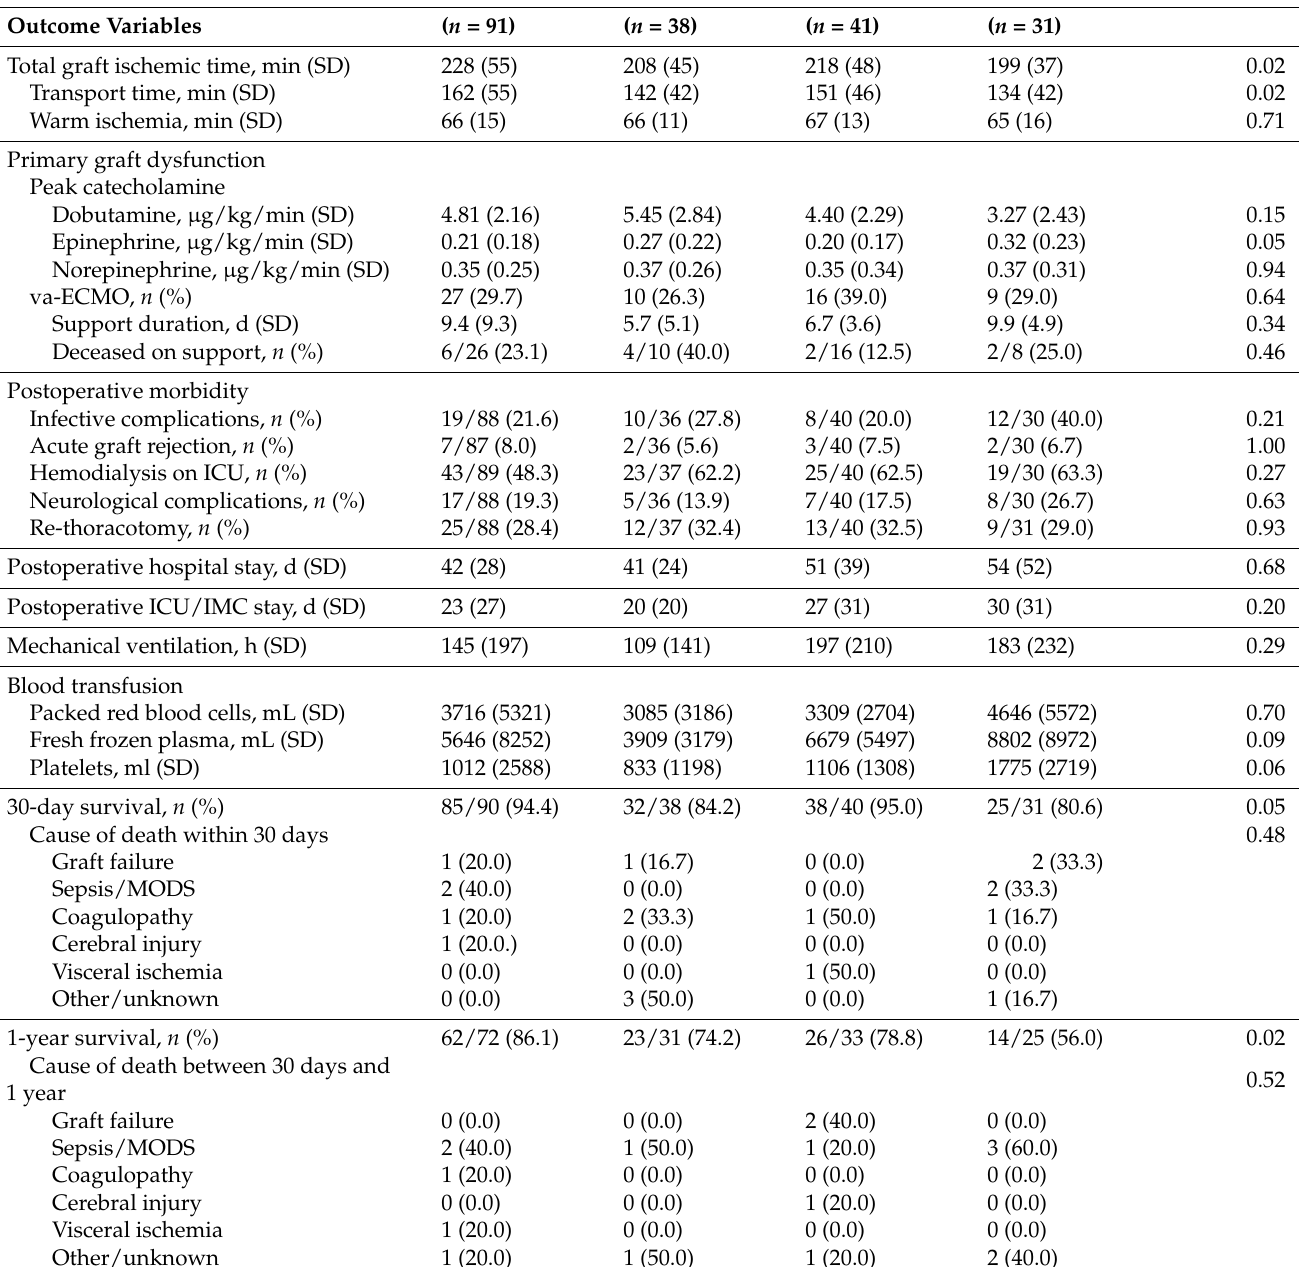
Table S1. ICU, intensive care unit; IMC, intermediate care unit; MODS, multiorgan dysfunction syndrome; SD, standard deviation; va-ECMO, veno-arterial extracorporeal life